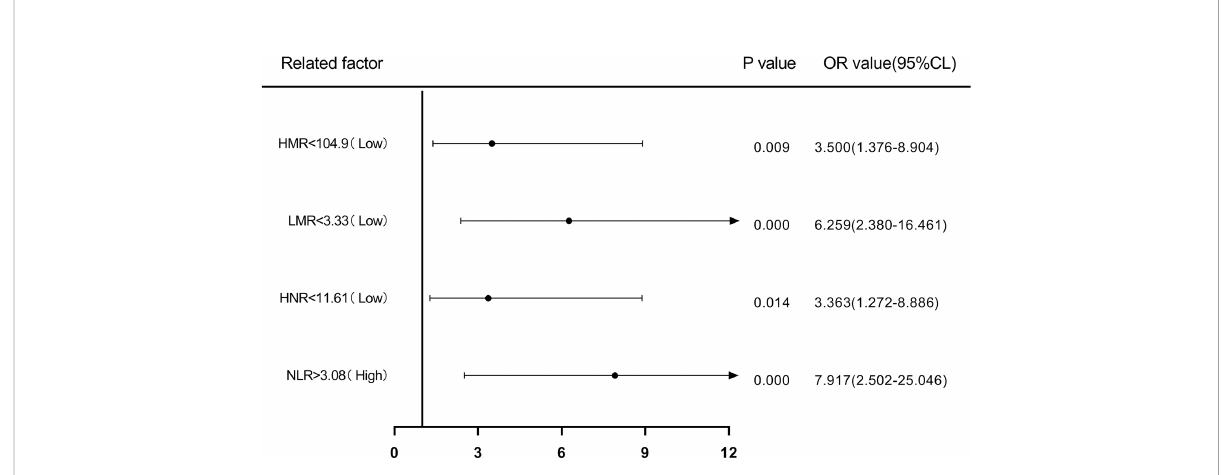
FIGURE 5 Forest plot of one-way logistic regression analysis of NLR, LMR, HNR, and HMR (two classi fi cation groups) in predicting NSCLC